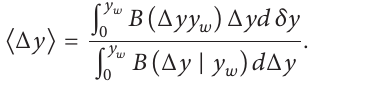
Figure 18: (a) The balance function width ⟨Δ𝜂⟩ for all charged particles from Au+Au collisions at √𝑠 of BF calculated using shuffled events. The balance function widths for p+p and d+Au collisions at √𝑠 UrQMD and HIJING calculations are shown for the widths of BF from Au+Au collisions. (b) The same as in (a) but for identified charged pions and charged kaons. The width of BF for pions predicted by the blast-wave model [39] is also shown. The figure is taken from